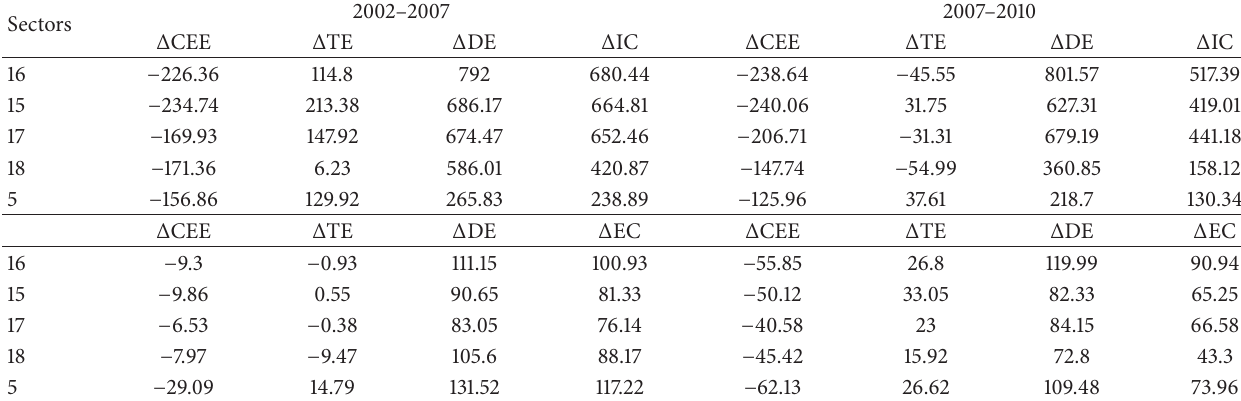
Table 3: Structure decomposition analysis of the key